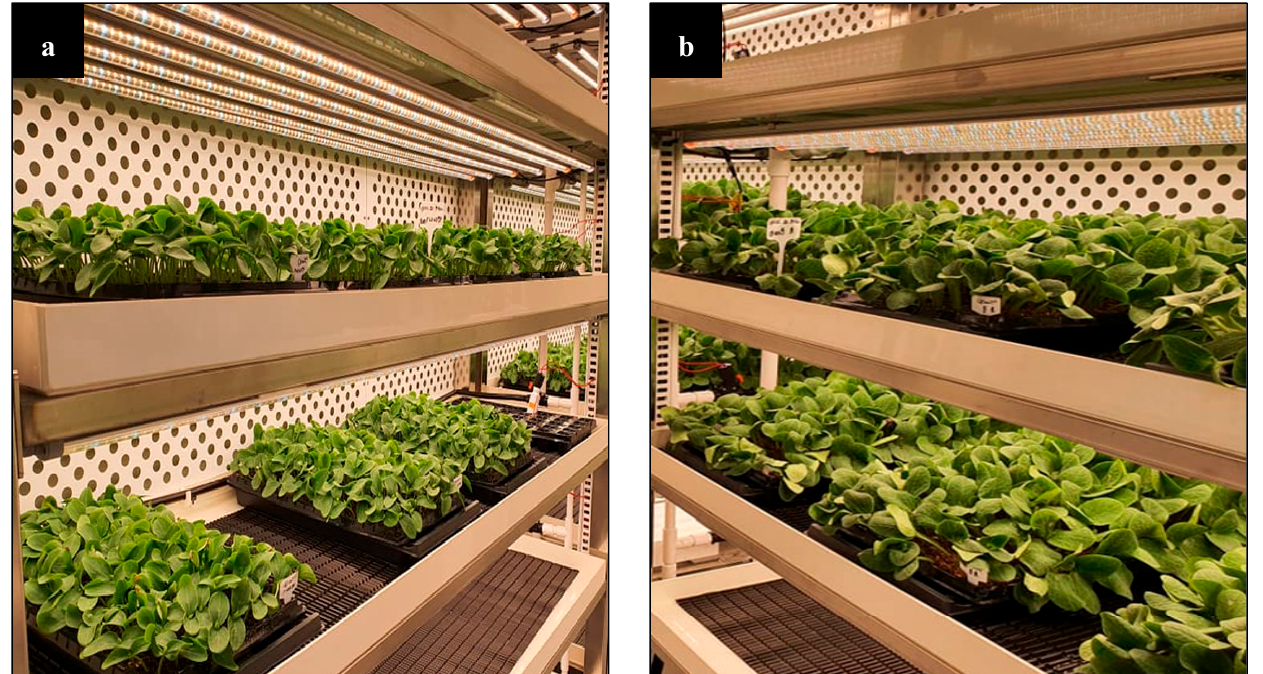
Figure 1. Cucumber scions ( a ) and rootstocks ( b ) cultivated in a PFAL.